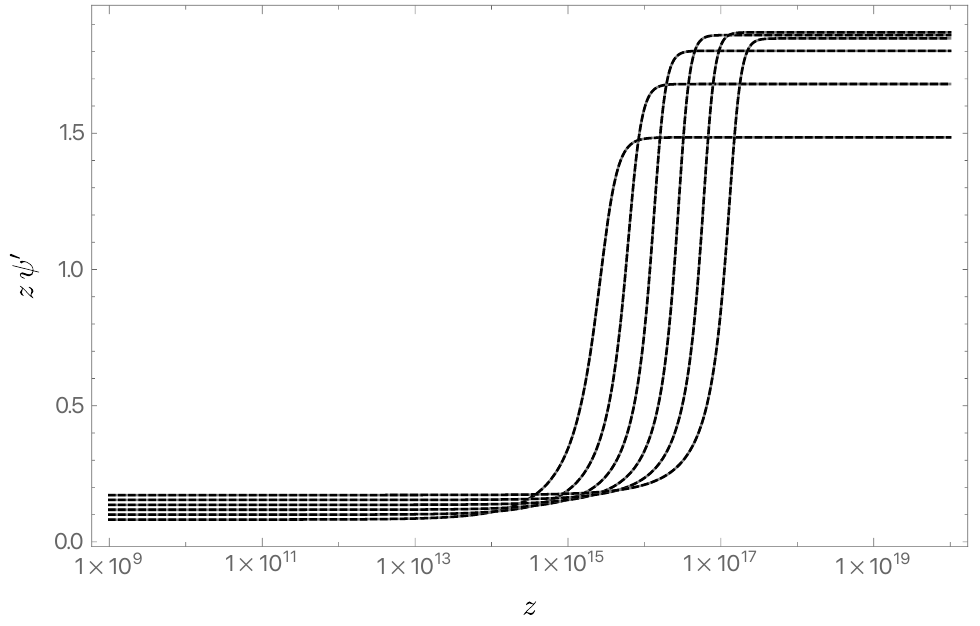
Figure 4 . Kasner transitions between S | z (cid:28) z = β and S | z (cid:29) z = β new where z tr is the location of tr tr the transition. This is for α = 1 , q = m, mM = 0 . 5 and the different curves have different β , namely (from bottom to top on the left side): β = { 0 . 82056 , 1 . 0004 , 1 . 1804 , 1 . 3606 , 1 . 5409 , 1 . 7212 } × 10 − 1 and Q/Q c − 1 = { 5 . 8918 , 5 . 8857 , 5 . 8796 , 5 . 8735 , 5 . 8674 , 5 . 8613 }× 10 − 5 . For each curve, the gray solid line is the numerical solution of (2.4) and the dashed black line is the solution of the approximated ODE (4.23): they are superposed.